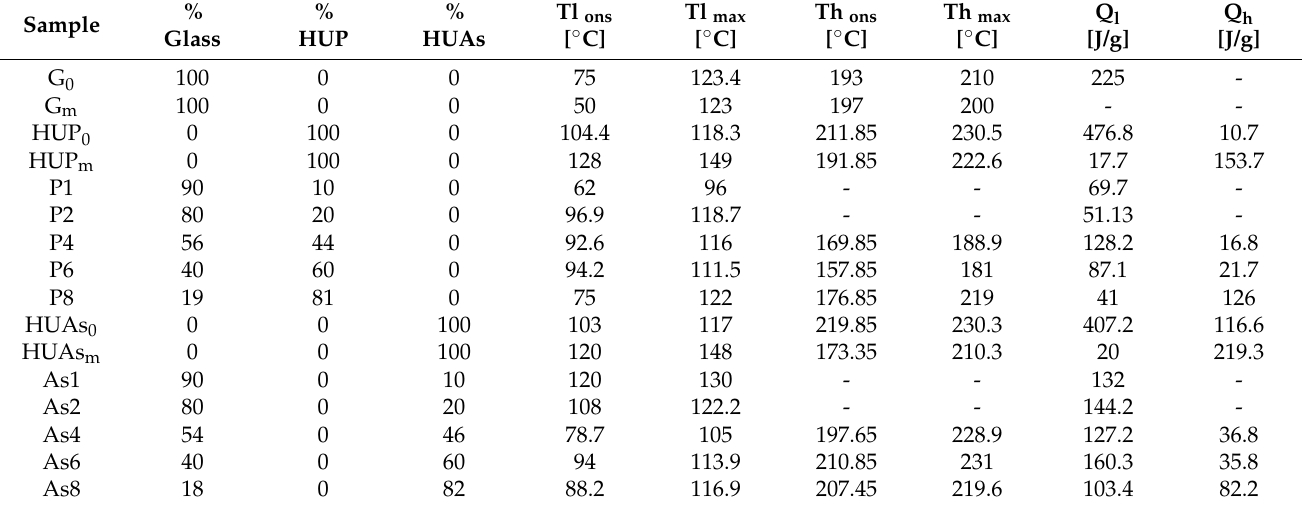
Table 1. Stechiometry and calorimetric data gathered and determined for the selected materials